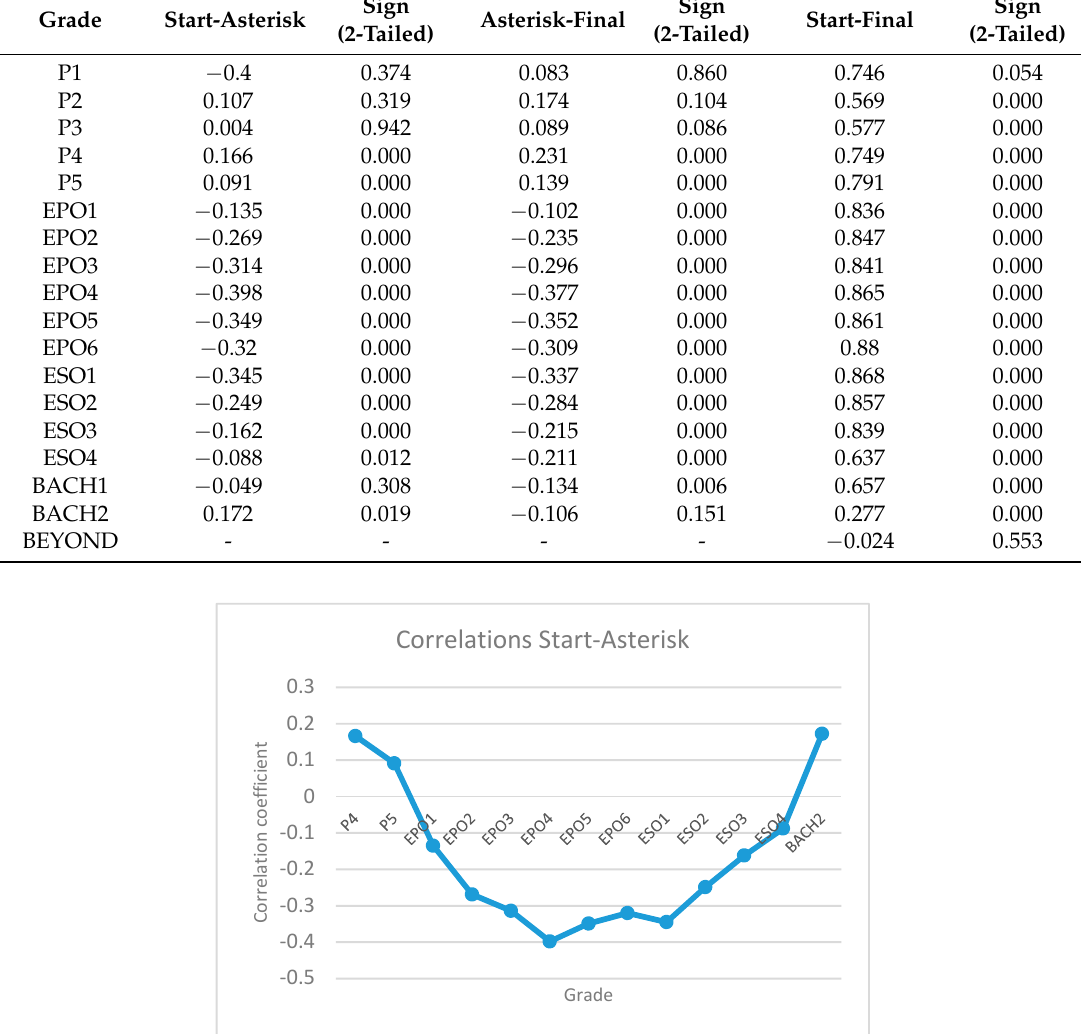
Table 3. Correlations between variables per school grade.